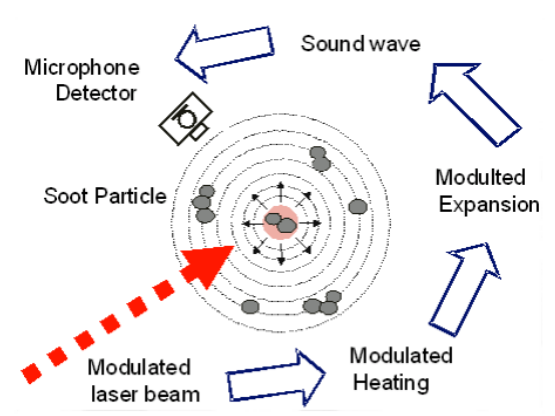
Figure 4. The principle of the photoacoustic measurement [12]. The diagram of the design of a resonant cell is shown in Figure